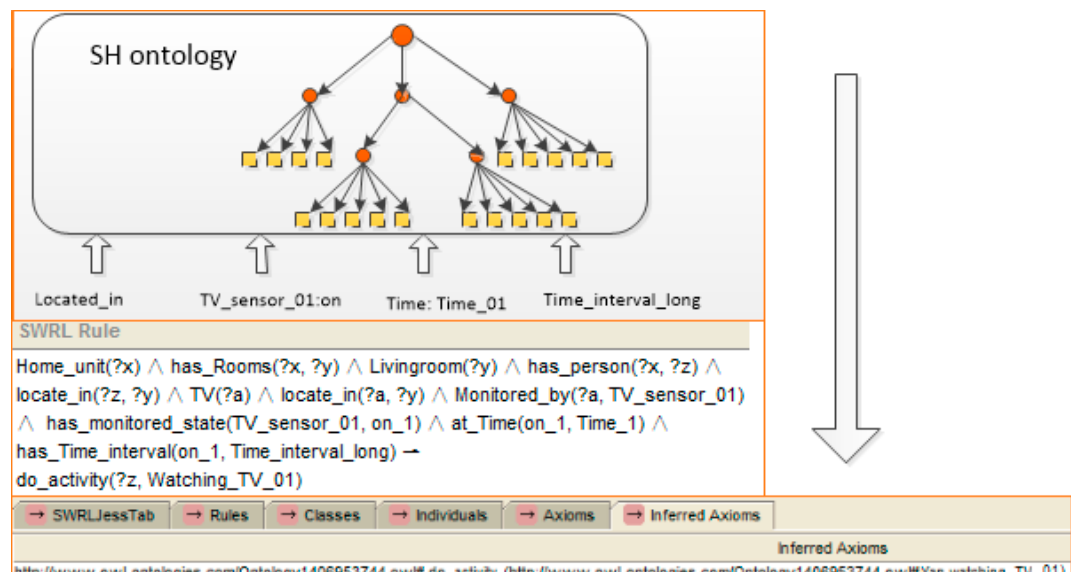
Figure 18. The reasoning process of activity ‘watching TV’.